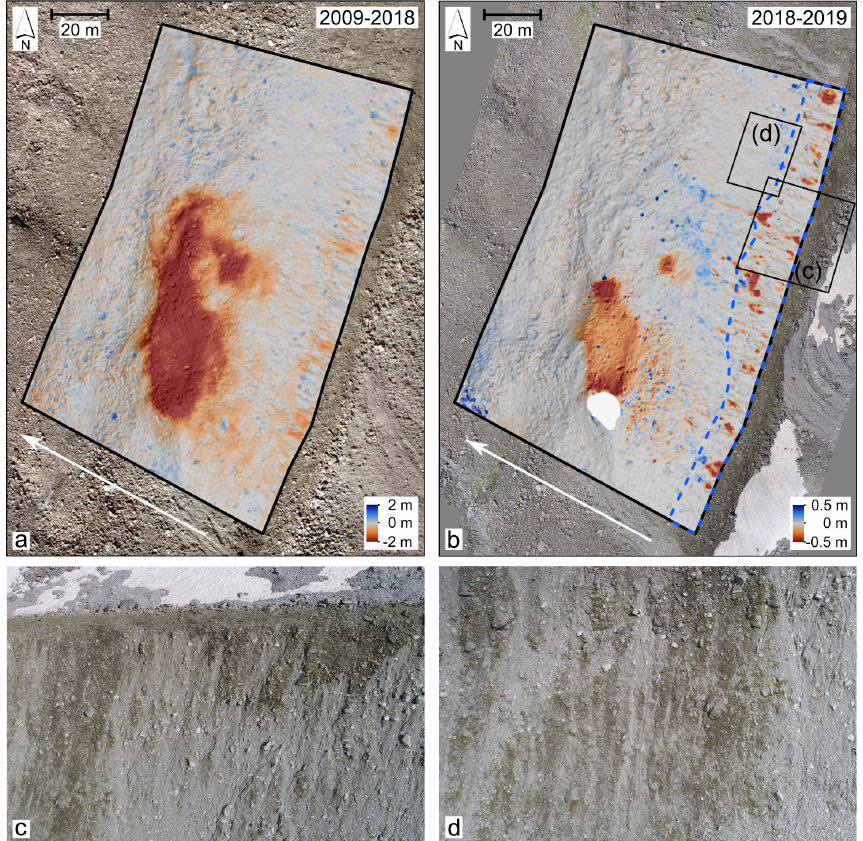
Figure 9. Slope with shallowly incised gullies or rills illustrated for moraine section APF2 in the Alpeiner Ferner forefield: (a) 2009–2018 DoD (the aerial images from 2009 are from the State of Tyrol, Austria), (b) 2018–2019 DoD with the erosion area (blue), and (c, d) drone images of the slope from 1 August